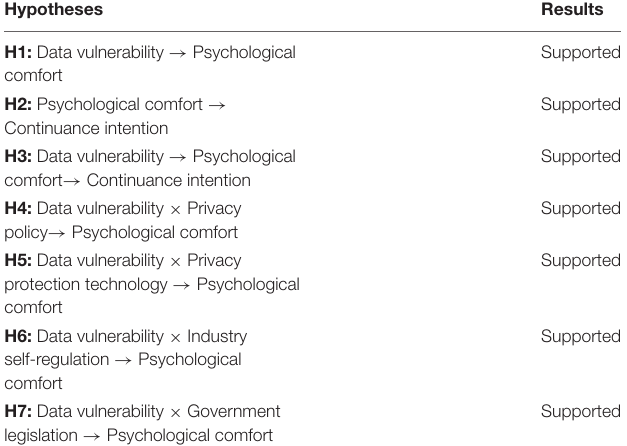
TABLE 5 | Summary of hypotheses testing.